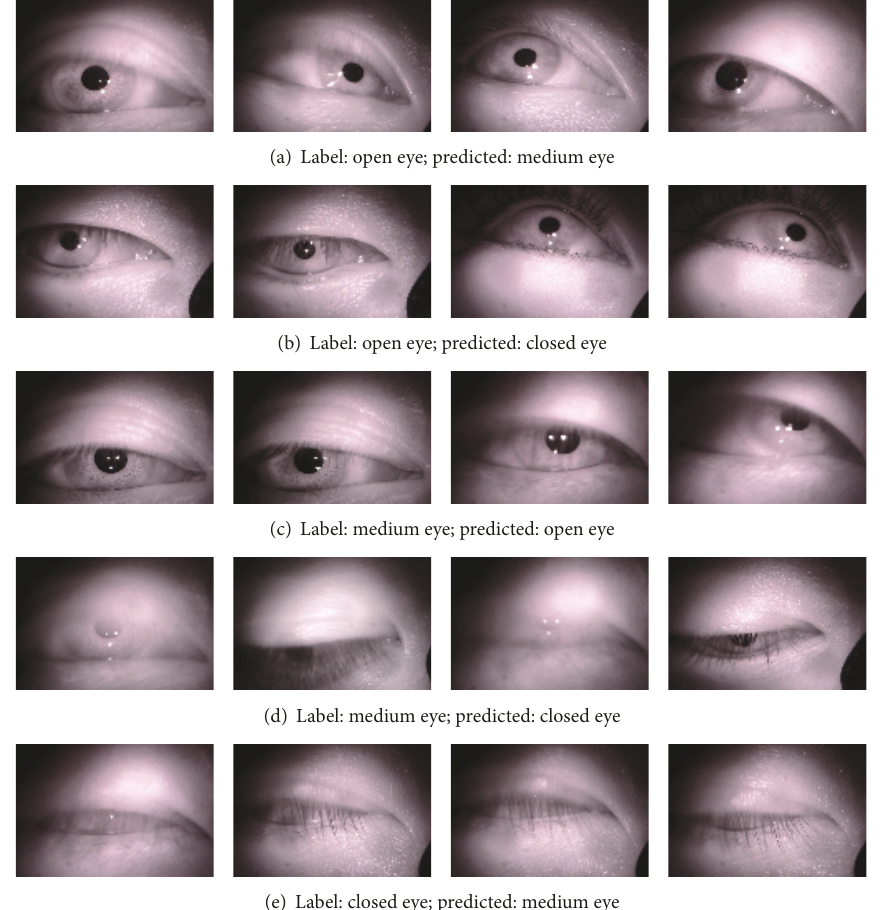
Figure 6: Sample images from the failed classification model.